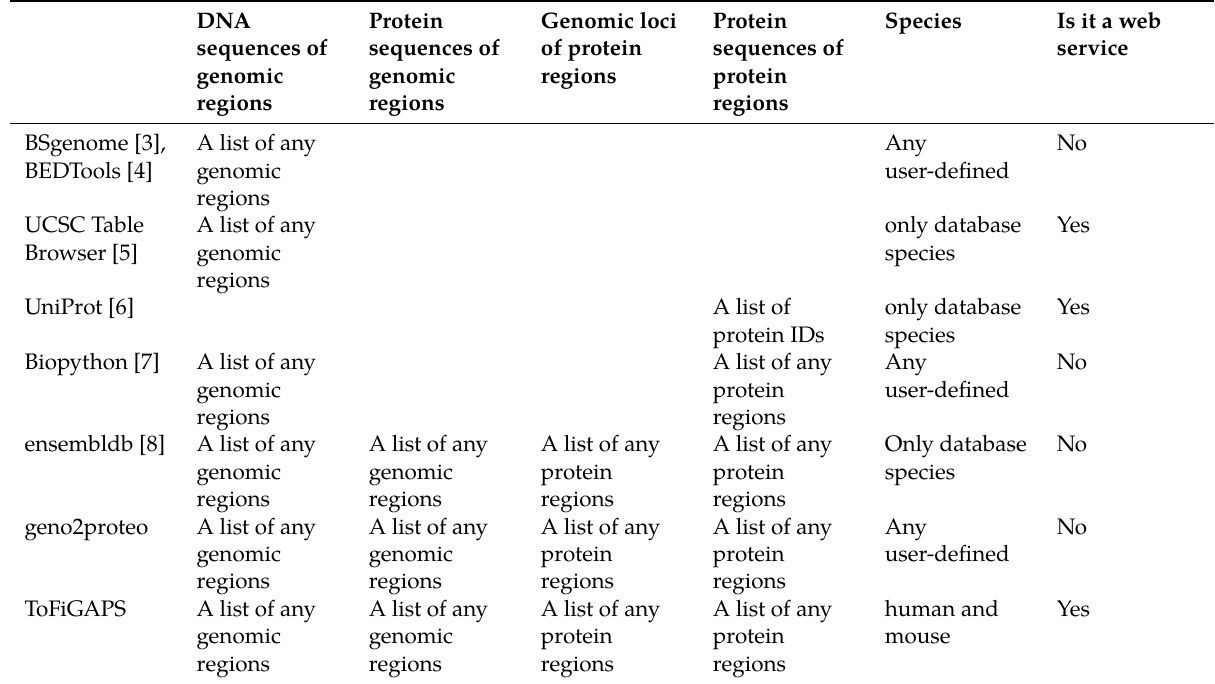
Table 1: Comparing geno2proteo with other public software on the four tasks. Tasks are shown in the first four columns headings (bold) whereas the table content indicates the capability of each of the indicated software packages on each